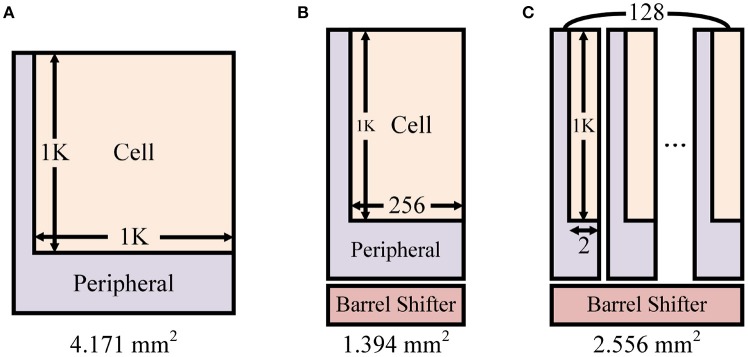
Different SRAM crossbar synapse memory design scenarios for 1K axons/neurons: (A) 1K × 1K crossbar, (B) 1K × 256 crossbar with a barrel shifter for the axonal offset concept, and (C) Split memory blocks (128 blocks) of 1K × 256 crossbar for the transposable addressing scheme.